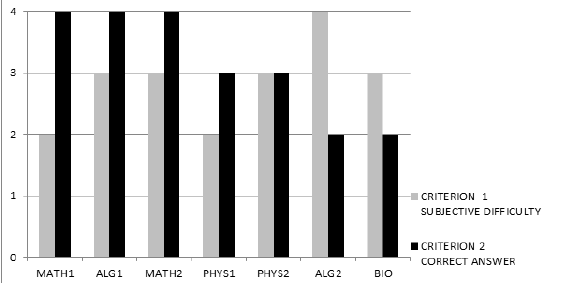
Figure 3. The task difficulty level according to the determined